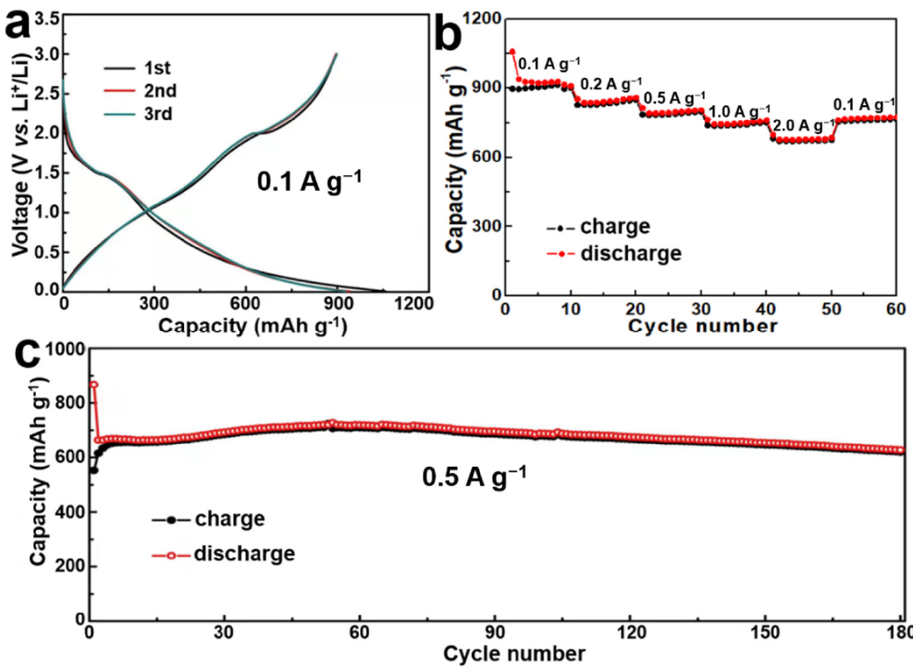
Figure 3. Electrochemical properties of the CoSeO 3 · 2H 2 O nanoflowers: ( a ) charge-discharge curves for the first three cycles at a current density of 0.1 A g −1 ; ( b ) rate capability at various current densities; ( c ) cycling performance at 0.5 A g −1 .